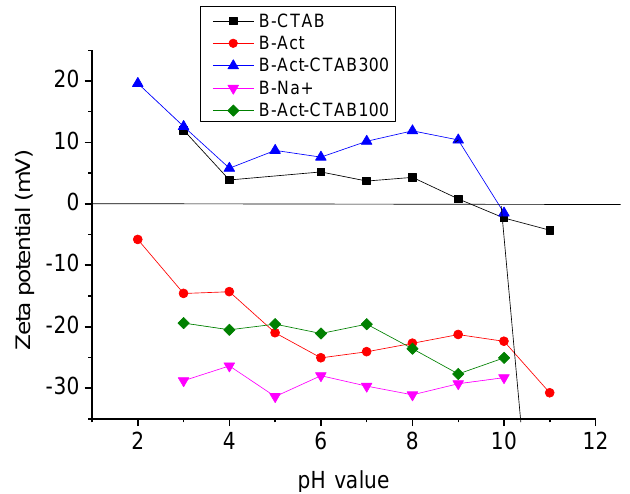
Figure 7. Zeta potential as function of pH of bentonite compared to all synthesized samples. The isoelectric point can be determined by the intersection of the zeta potential as a function of pH, with the x-axis at zeta potential equal to zero. The zeta potential of the studied dispersions shows distinct values between (B-CTAB and B-Act-CTAB300) on one side, and (bentonite, B-Act and B-Act-CTAB100) on the other side. In the range from pH = 2 to 11, the latter ones remain negatively charged for all pH values. An increase of pH provokes an increase of the negative charge. These samples did not show an isoelectric point because isomorphic substitution remains independent of pH in the acidic range. Under basic conditions, the edge surface of bentonite and B-Act, where the octahedral/tetrahedral sheet is broken, can be assimilated with the surface of alumina or silica particles [54]. The hydroxyl ion acts like an ion, determining the Zeta potential, and provokes a negative charge of the surface of the edge